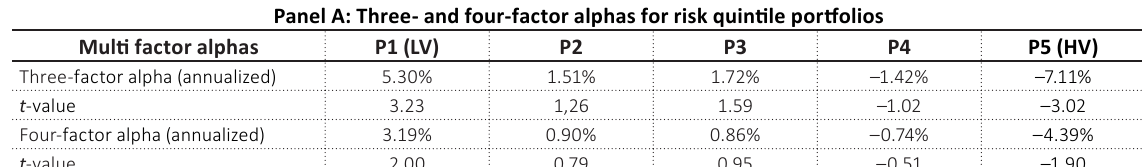
Panel B: Three- and four-factor regression coefficient